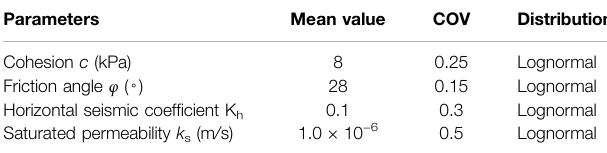
TABLE 1 | Statistical properties of parameters used in this example.